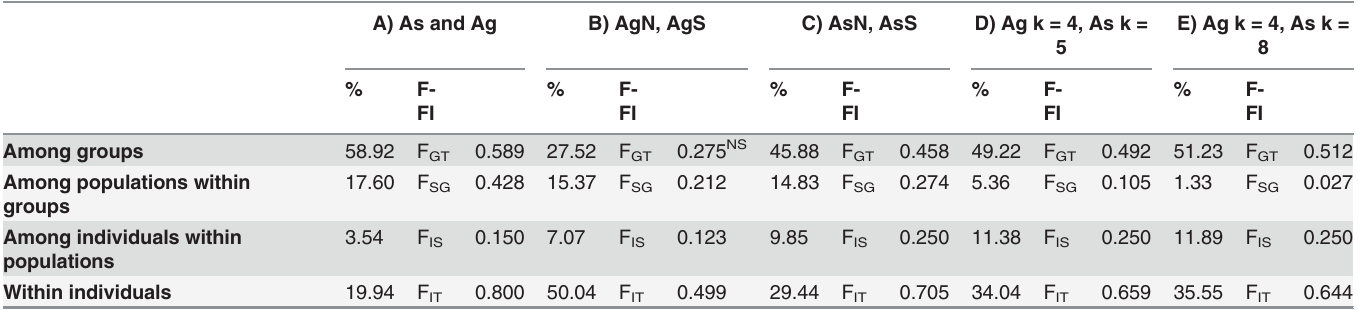
Table 4. Analysis of molecular variance (AMOVA) for A . germinans and A . schaueriana